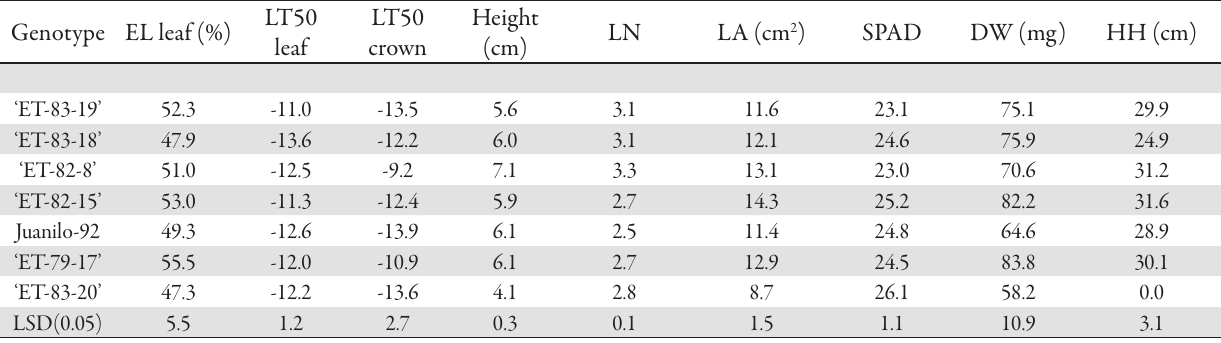
Tab. 4. Plant parameters of different genotype exposed to freezing temperature Genotype EL leaf (%)